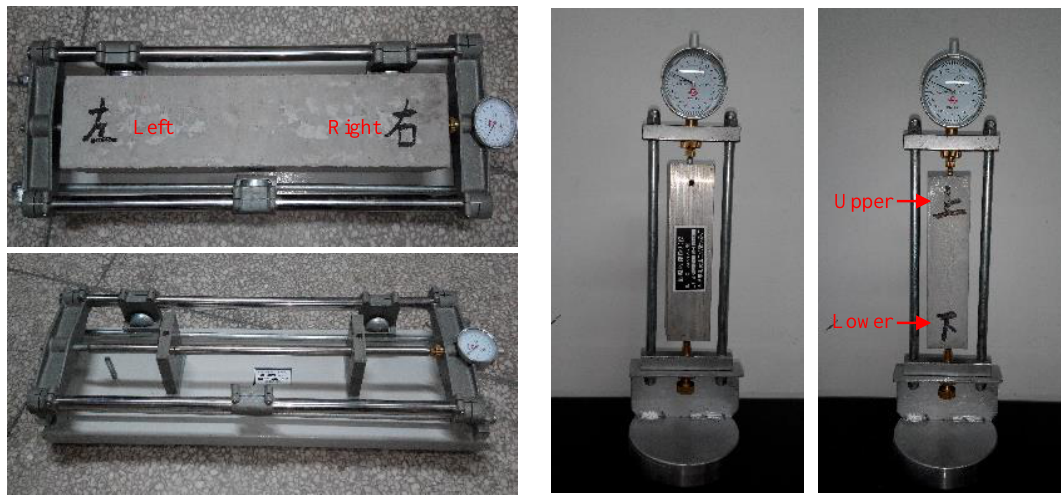
Figure 2. Free shrinkage measurement of SHCC and concrete.